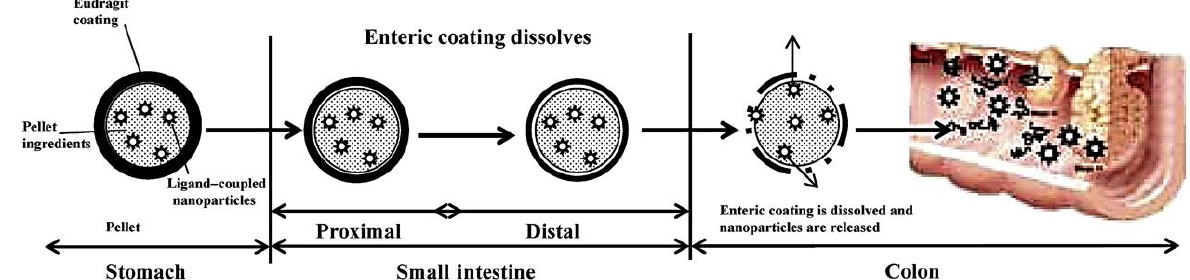
Figure 9. Mechanistic system of Eudragit-coated pellets encapsulating nanoparticles for colon-specific targeting [93], reproduced with permission from Elsevier.